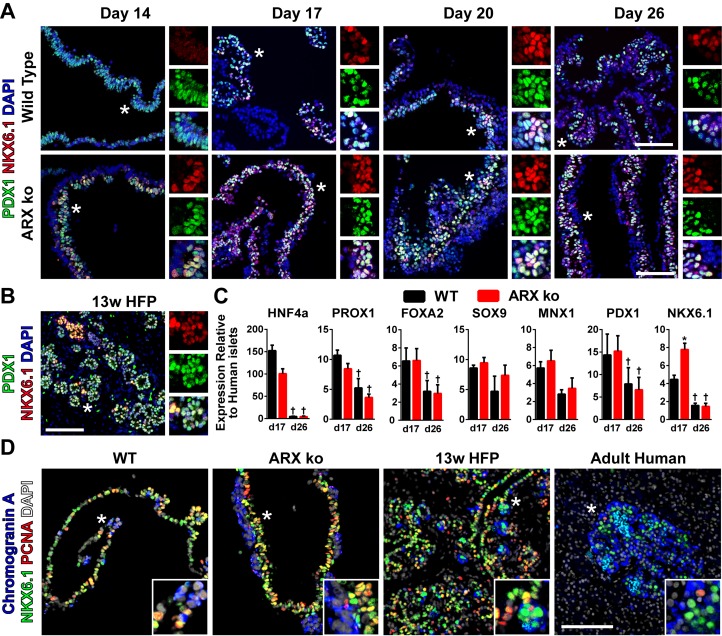
Pancreatic Progenitors in ARX ko hESCs.(A) Immunostaining of PDX1 (green) and NKX6.1 (red) in agarose-embedded wild type (WT) and ARX knockout (ARX ko) cell sheets from day 14, 17, 20, and 26 of culture. * indicates region of enlargement (right) which includes individual red and green channels and overlay with DAPI (blue) showing coexpression patterns. (B) Immunostaining of 13 week human fetal pancreatic tissue the same as A. (C) RT-qPCR of day 17 and day 26 whole population samples examining the expression of transcription factors believed to be involved in pancreatic progenitor induction. Wild type (black bars) and ARX ko clone 1 (red bars) cell samples relative to adult human islets expression levels. † indicates p < 0.05 within the genotype over time, * indicates p < 0.05 wild type vs ARX ko at given culture day, N = 4 per group. (D) Immunostaining of NKX6.1 (green), proliferating cell nuclear antigen (PCNA, red), and chromogranin A (blue) in 26 day differentiated wild type and ARX ko cells, 13 week human fetal pancreatic tissue, and adult human pancreatic tissue. Inset is a ~3x enlarged portion from the region indicated by the star. Scale bar is 100 μm for all panels.